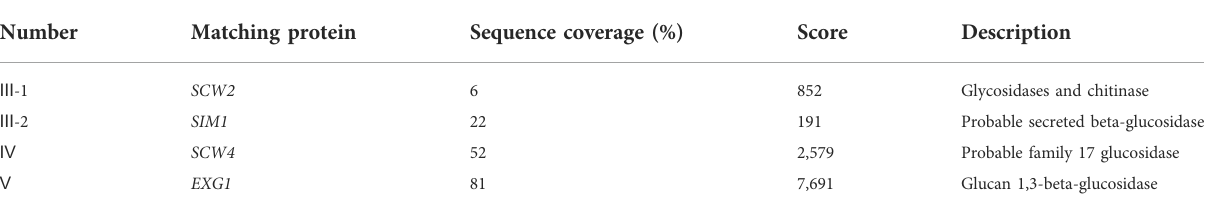
TABLE 2 Potential anthocyanin-degrading